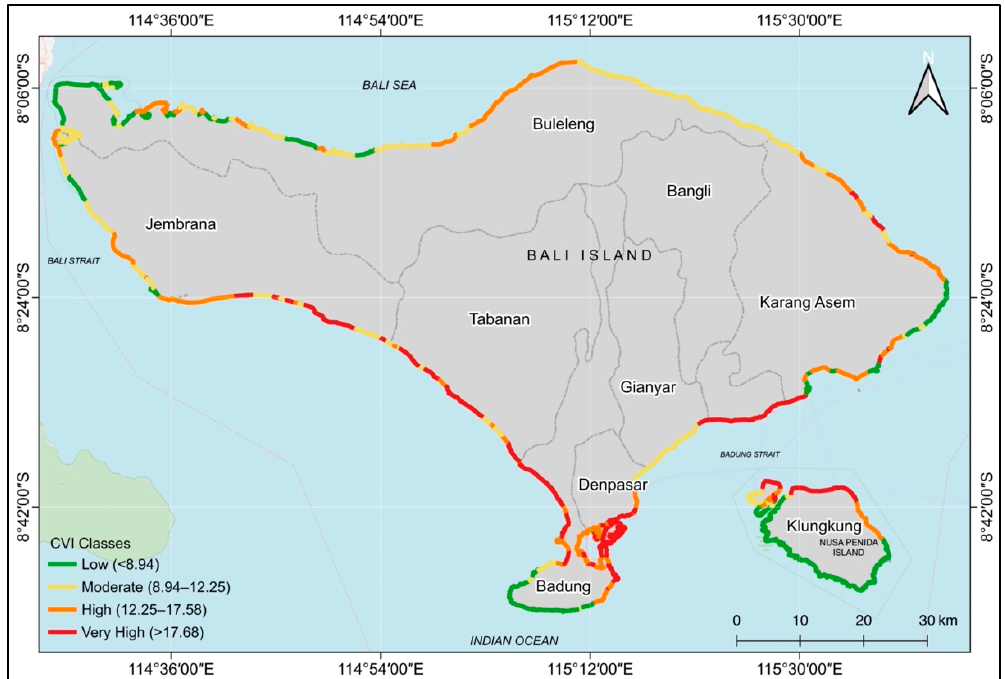
Figure 7. The coastal vulnerability index (CVI) map of Bali Province. Regions with moderately vulnerable zones are formed by variations in the geomor- phological parameters with alluvial plains and low cliffs, followed by an elevation of 10– 20 m. The rate of shoreline change due to accretion and erosion is in the range of − 1.1 to − 2 m/year and is the most dominant factor. Regions with moderate vulnerability are located in the eastern part of Buleleng (74.49 km), Jembrana (38.21 km), Karangasem (13.50 km), Klungkung (11.57 km), Gianyar (11.33 km), Tabanan (7.05 km), Badung (5.94 km), and Denpasar City (1.11 km). Regions with moderate vulnerability can also be categorized as safe regions; however, if those regions are not managed appropriately, they could become high or very high vulnerability